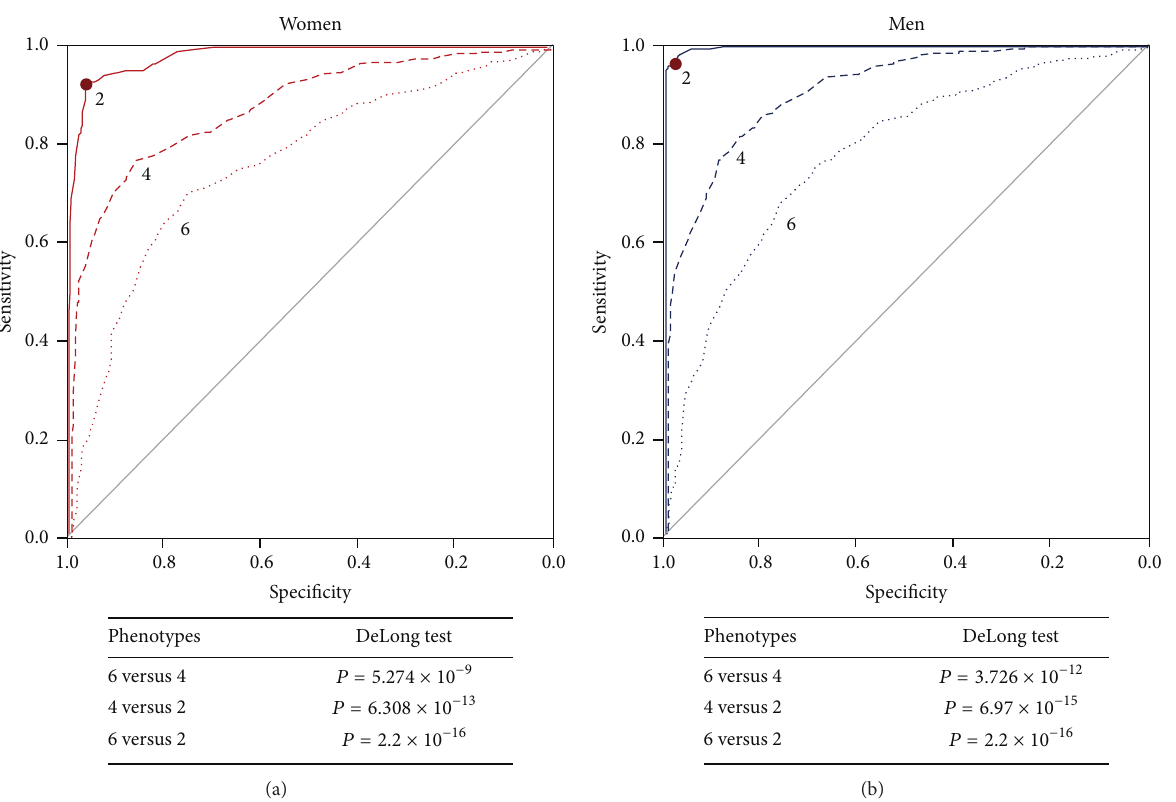
Figure 6: Comparison of the ROC curves constructed in the overall stepwise process for both men and women. Notice that the curves get closer to the 1.0 corner as the true healthy and sick subjects are being selected. The DeLong test results are shown as